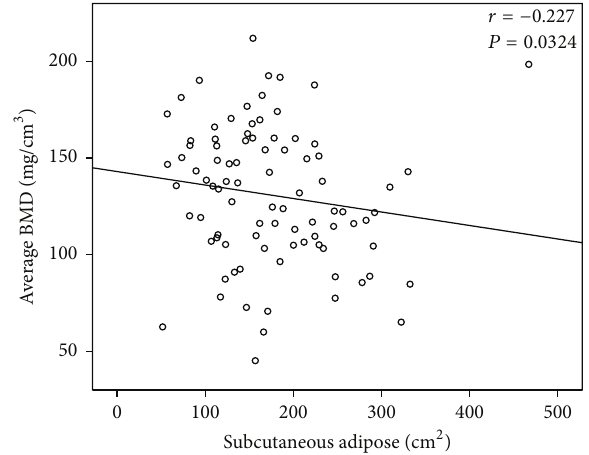
Figure 2: Correlation between average bone mineral density (mg/cm 3 ) and subcutaneous adipose tissue in group aged < 55. “ 𝑟 ” is the Spearman correlation coefficient.